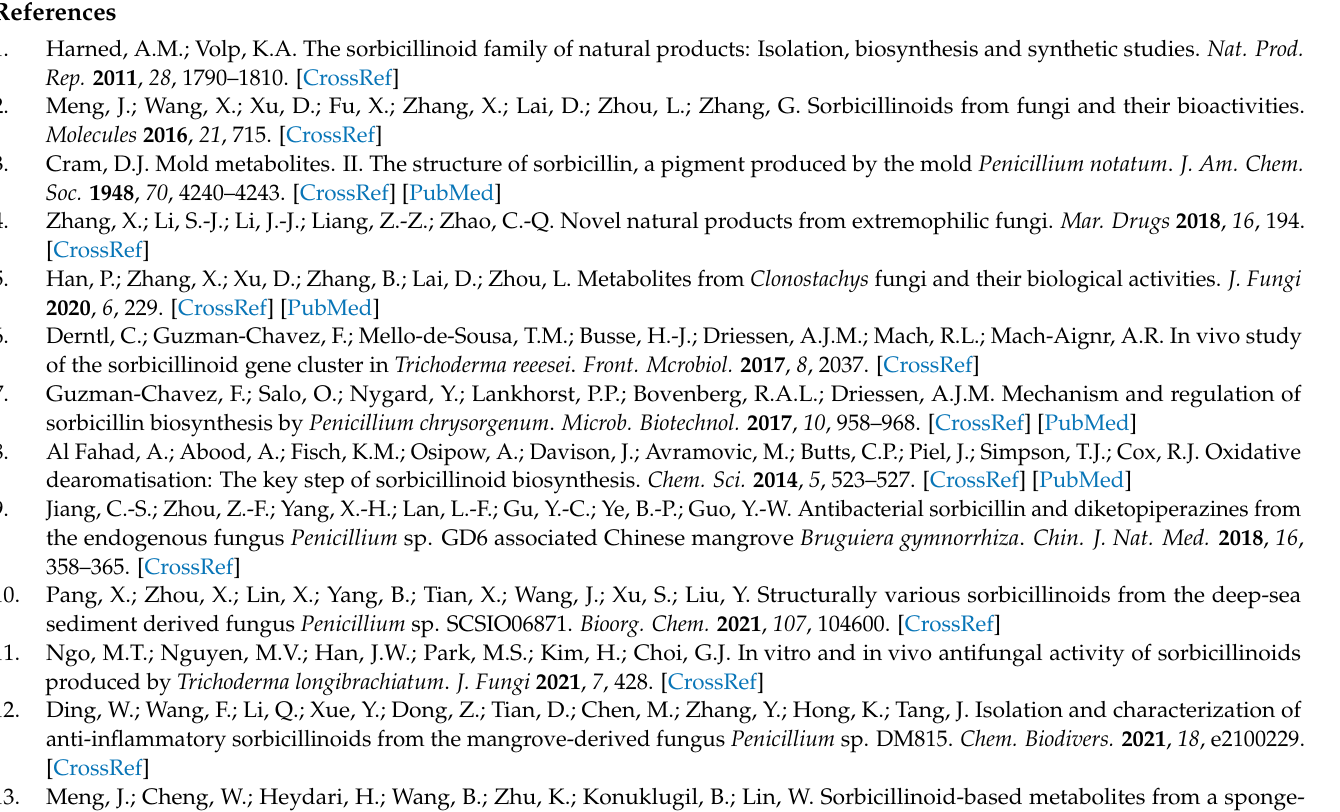
Table S6: Antifungal activity of the sorbicillinoids screened from fungi; Table S7: